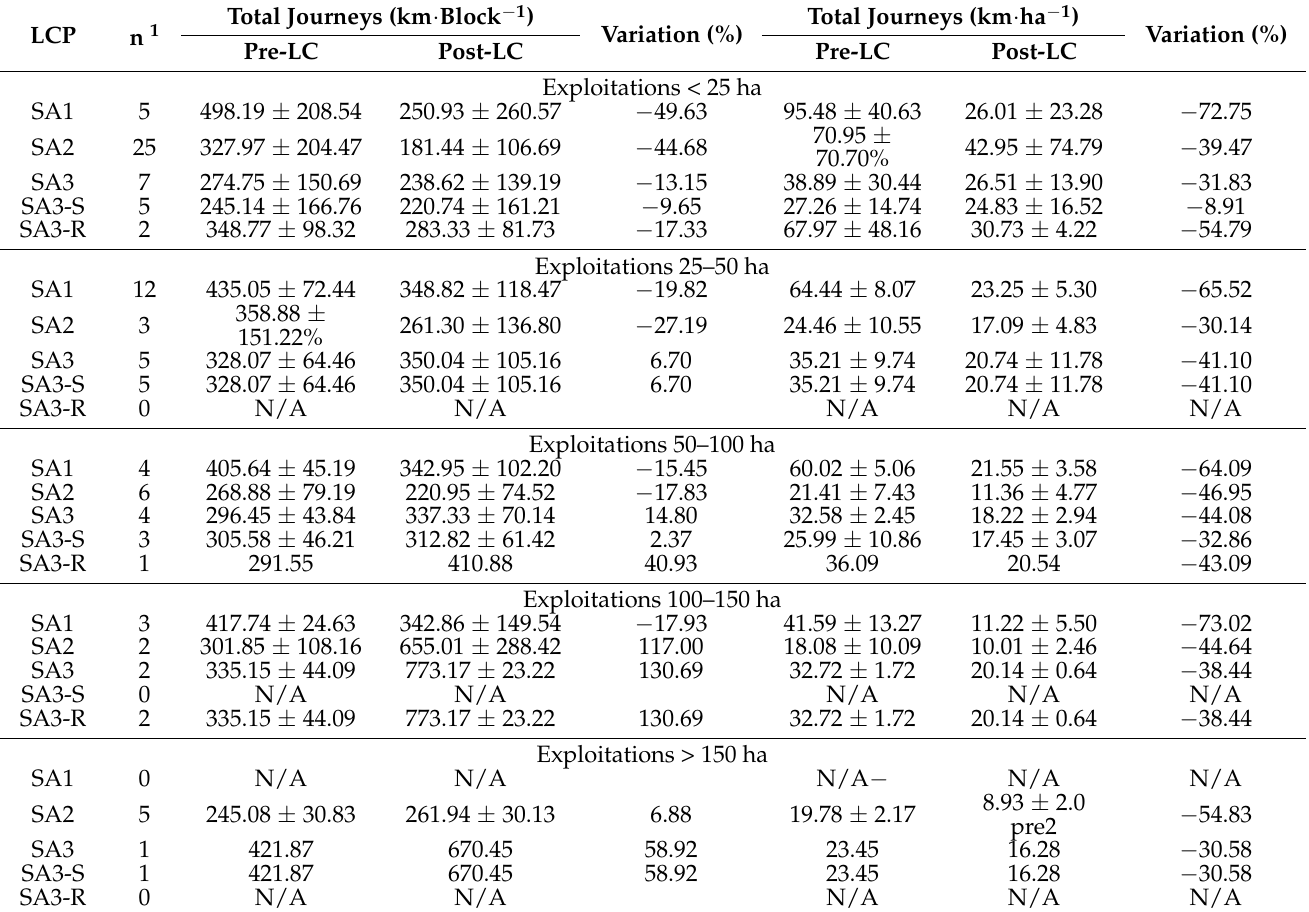
Table 6. Distribution of the journeys according to the size of the exploitations (pre-LC and